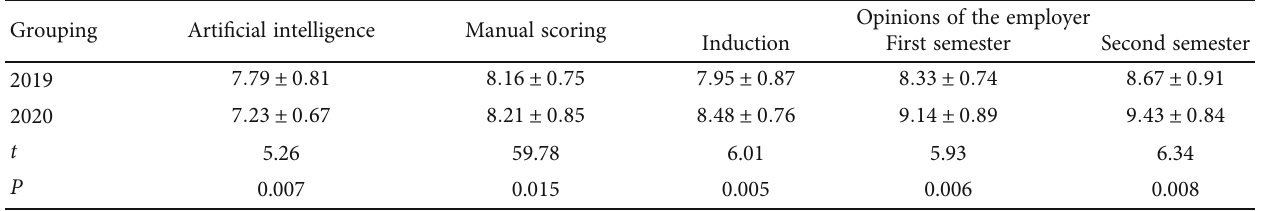
Table 2: Statistics of student aerobic referee scores (the data comes from the student fi les of the student o ffi ce of our university). Grouping